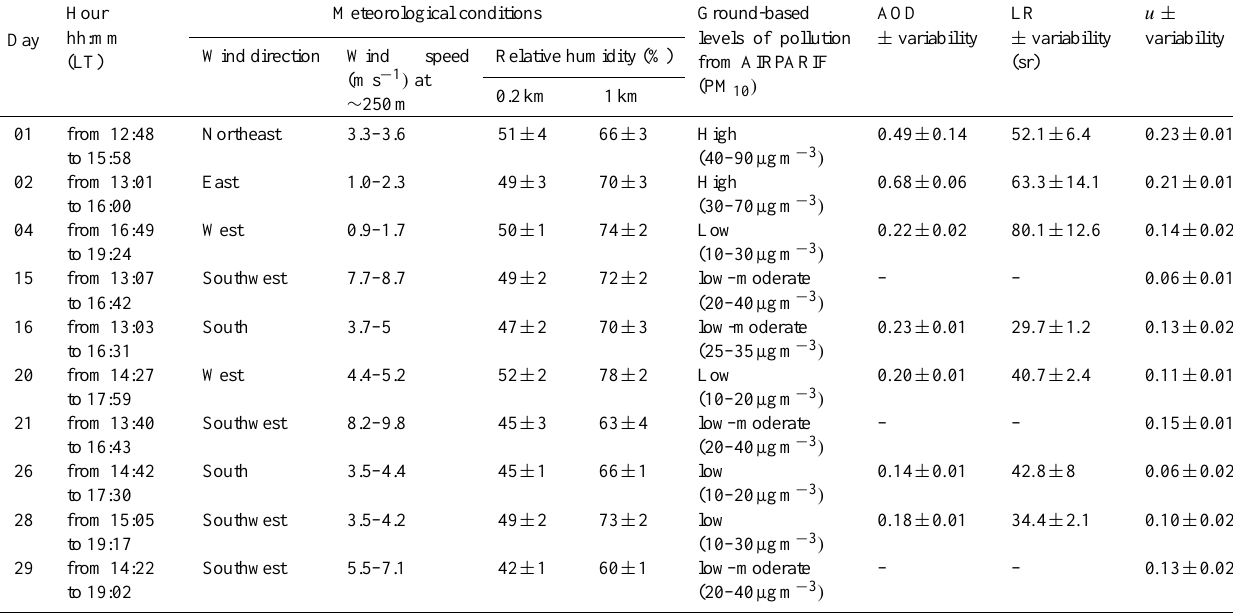
Table 2. Meteorological conditions (wind direction and velocity at ∼ 250m, relative humidity at ∼ 0.2km and 1km, levels of pollution (and PM 10 concentrations), mean AOD (and variability) at 355nm, mean LR (and variability) and mass increase coefficient u (and variability) during the 10 MD involving GBML during the MEGAPOLI summer experiment.